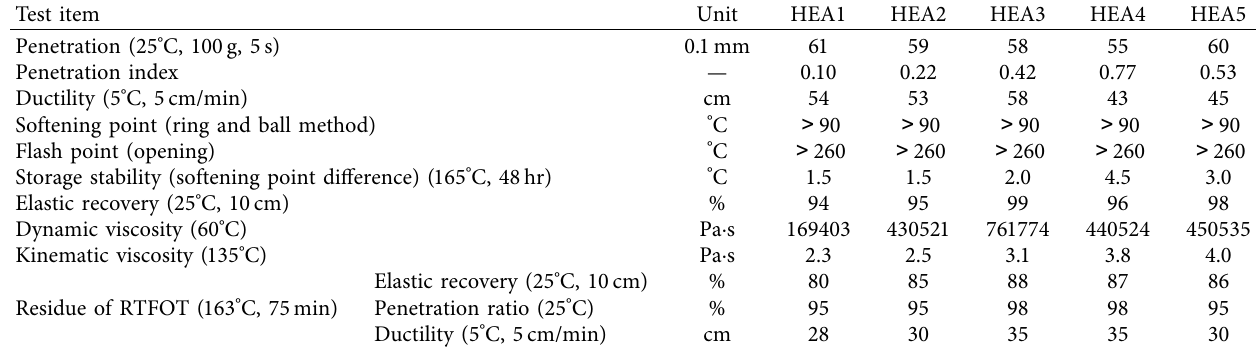
Table 1: Performance of different modified asphalt binders with various modifier dosages.